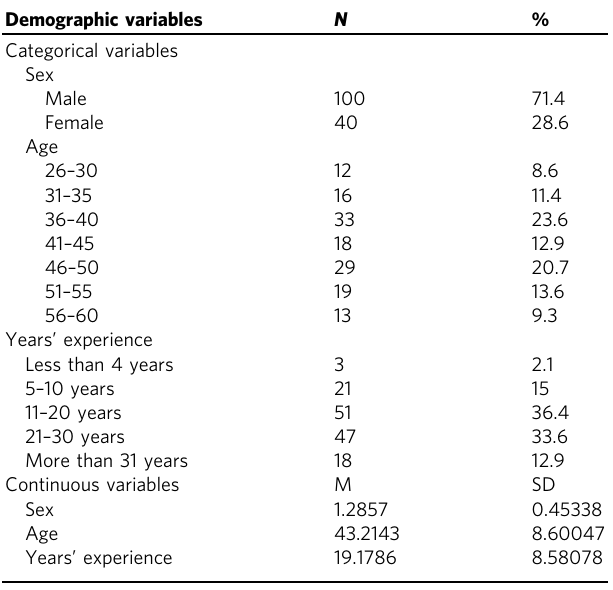
Table 1 Frequency distribution of demographic